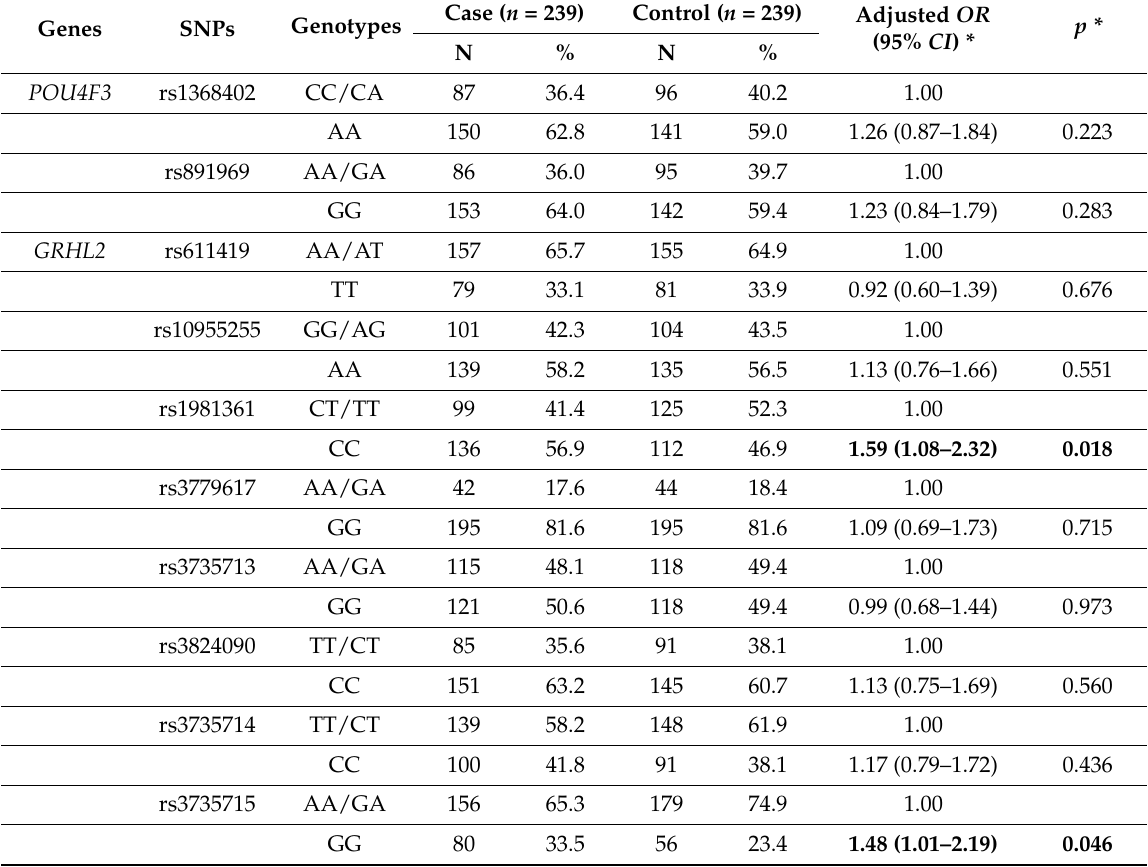
Table 2. Associations of candidate SNPs with the risk of